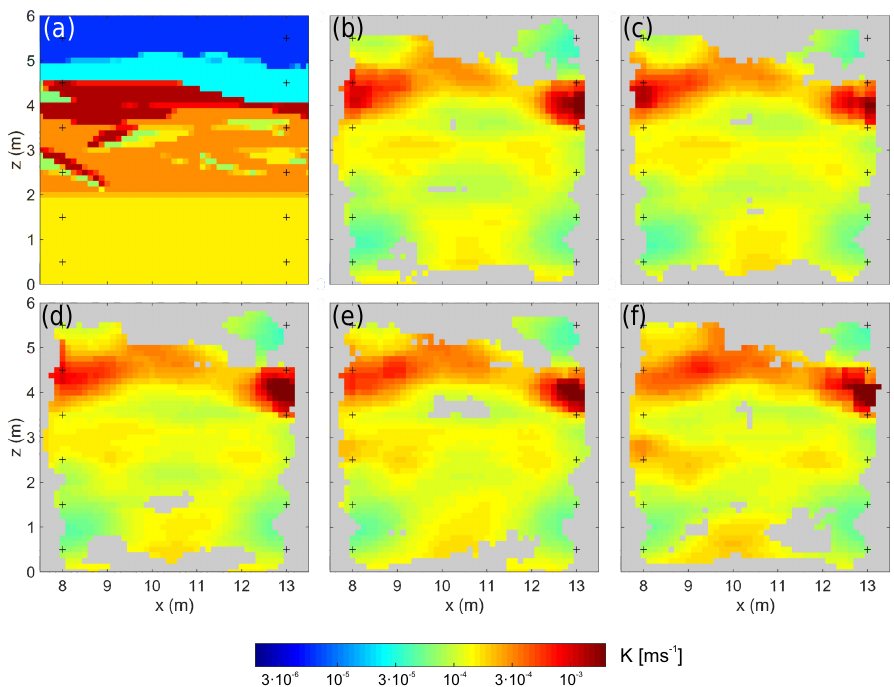
Figure 8. Hydraulic conductivity K reconstructions with different injection temperatures ( (cid:49)T ). (a) Original K profile, (b) (cid:49)T = 5 ◦ C, (c) (cid:49)T = 10 ◦ C, (d) (cid:49)T = 20 ◦ C, (e) (cid:49)T = 40 ◦ C, (f) (cid:49)T = 80 ◦ C.